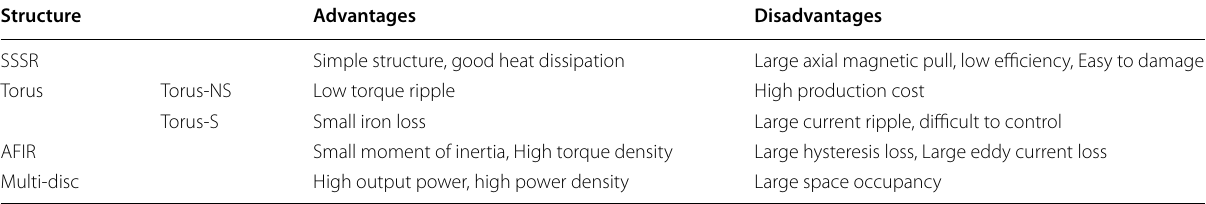
Table 2 Advantages and disadvantages of various AFPMSM structures